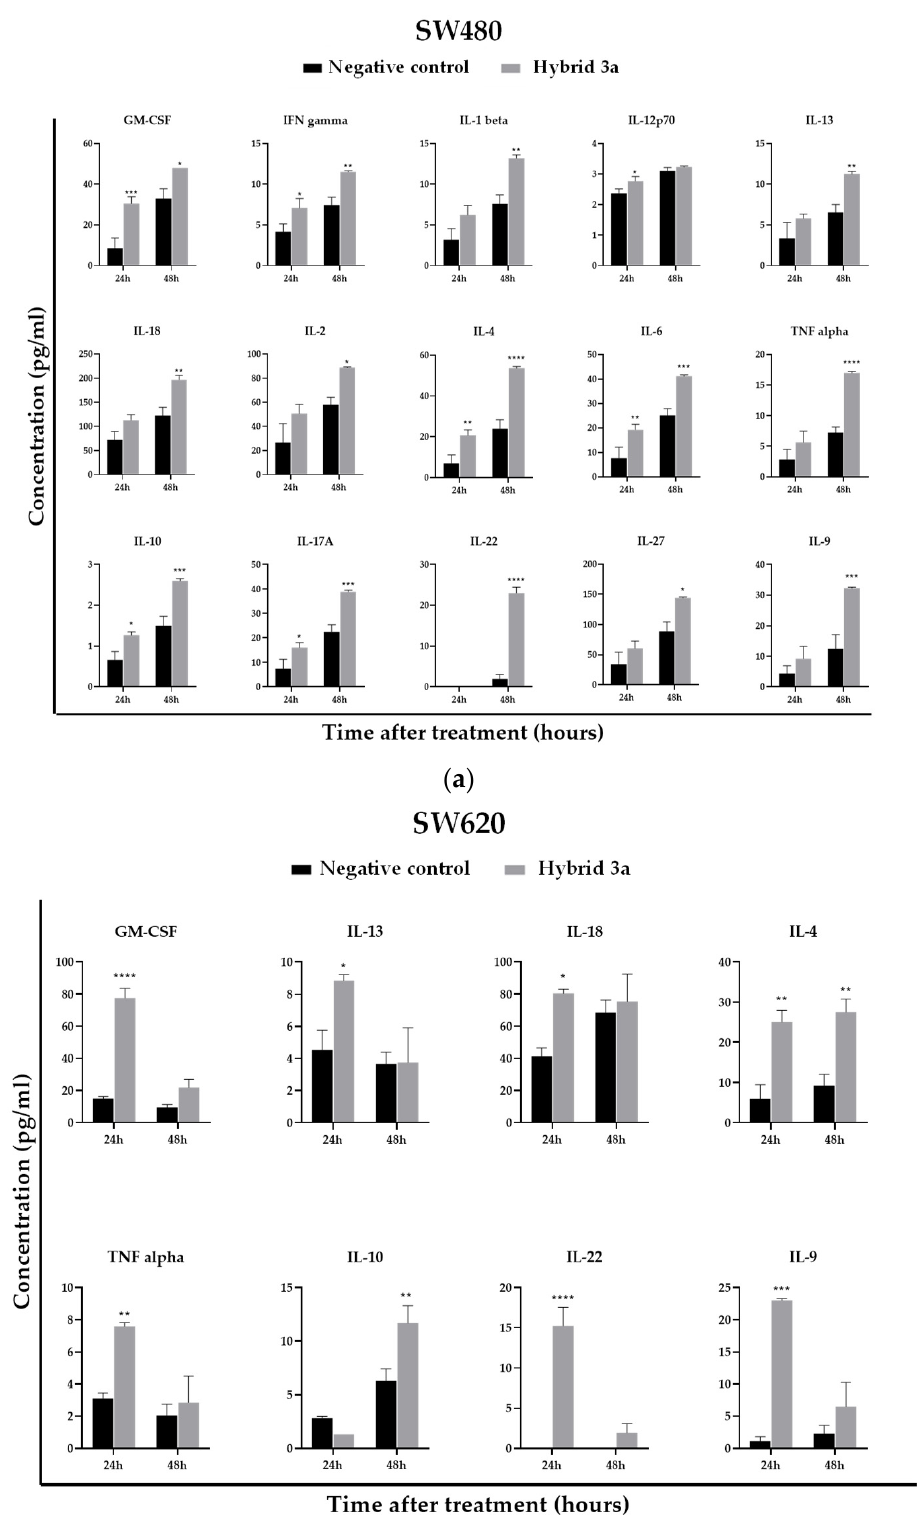
Figure 5. Levels of immunological markers associated with the inflammatory process in the ( a ) SW480 and ( b ) SW620 cell lines at 24 and 48 h post-treatment with hybrid 3a . Data are presented as the mean ± SE of at least three replicates (* p < 0.05; ** p < 0.01; *** p < 0.001; **** p < 0.0001 vs. negative